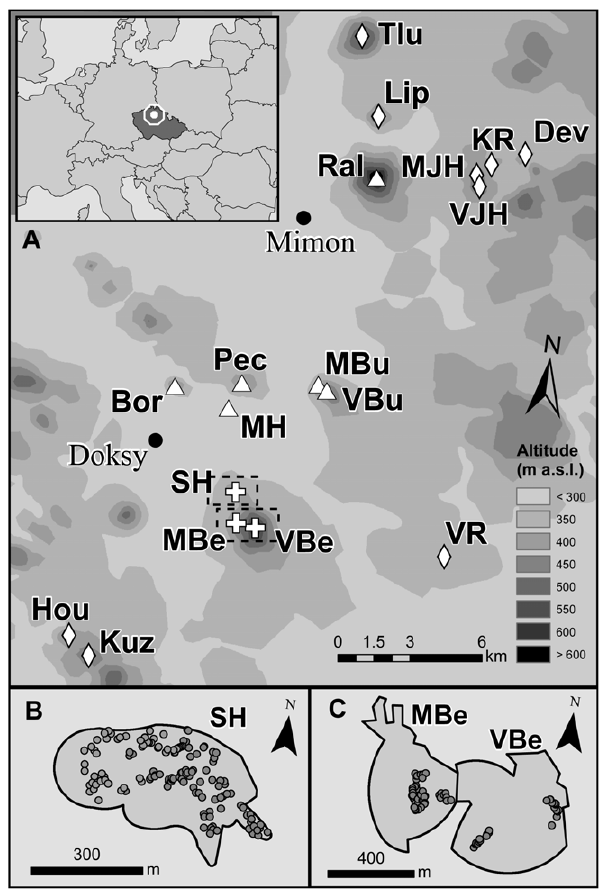
Figure 4. Ralska Upland, Czech Republic. Distribution of the Rosalia longicorn in the Ralska Upland (a), and the distribution of trees and dead-wood on (b) Slatinne Hills (SH), (c) Maly Bezdez (MBe) and Velky Bezdez (VBe), where the mark-recapture study took place. Eighteen sites with mature beech forest were found within the depicted area. Searching for individuals and exit holes revealed that three sites host large populations ( . 500 adults a year, adults regularly found and abundant: crosses), six sites host very small populations ( , 10 exit-holes found, adults occasionally reported: triangles), while no evidence of the beetle presence was found on the remaining nine sites (diamonds). Within the area depicted (69 100 ha), forests cover 55.5% (38 338 ha of mostly conifer plantations), mature-beech forests covered MBu: Mala Bukova, MBe: Maly Bezdez, MJH: Maly Jeleni Hill, MH: Mlynsky Hill, Pec: Pecopala, Ral: Ralsko, SH: Slatinne Hills, Tlu: Tlustec, VBu: Velka Bukova, VBe: Velky Bezdez, VJH: Velky Jeleni Hill, VR: Velky Radechov.